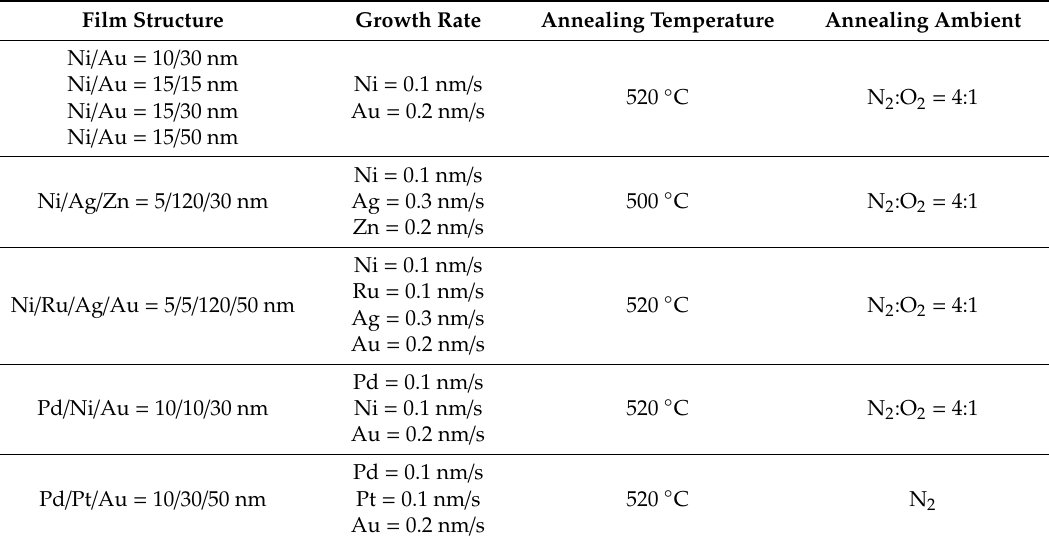
Table 1. The detail of p electrode metal alloy films growth parameter and annealing